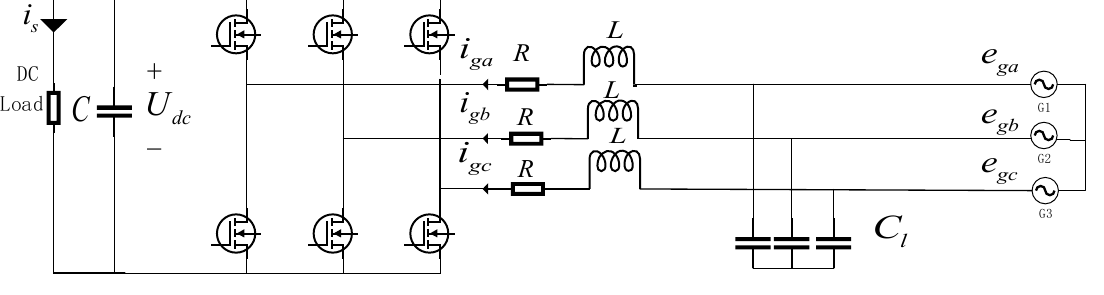
Figure 1. Topology of grid-connected inverter.